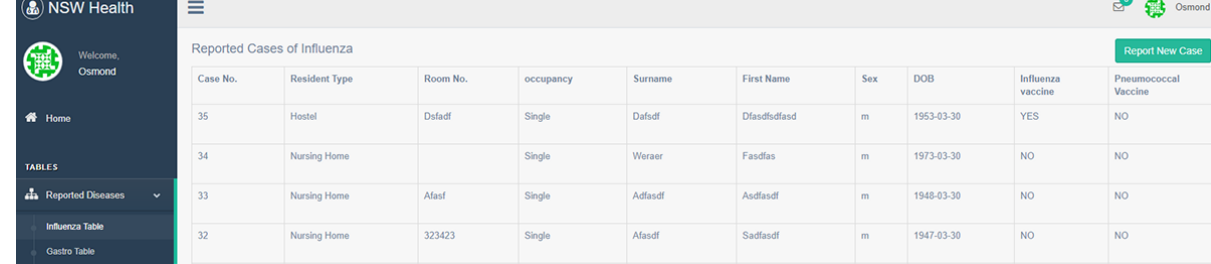
Figure 7. Details of the reported cases of infectious diseases. The Hypertext Preprocessor (PHP) Laravel framework is a popular and standard development framework that follows a model view controller architecture pattern.